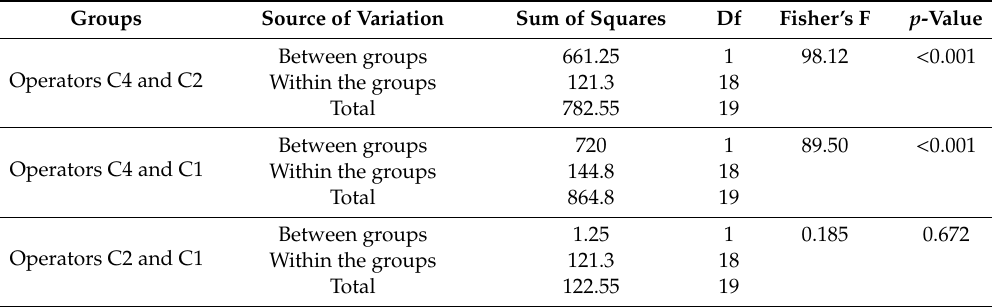
Table 2. Analysis of variance of the total number of false aneurysms (FA).